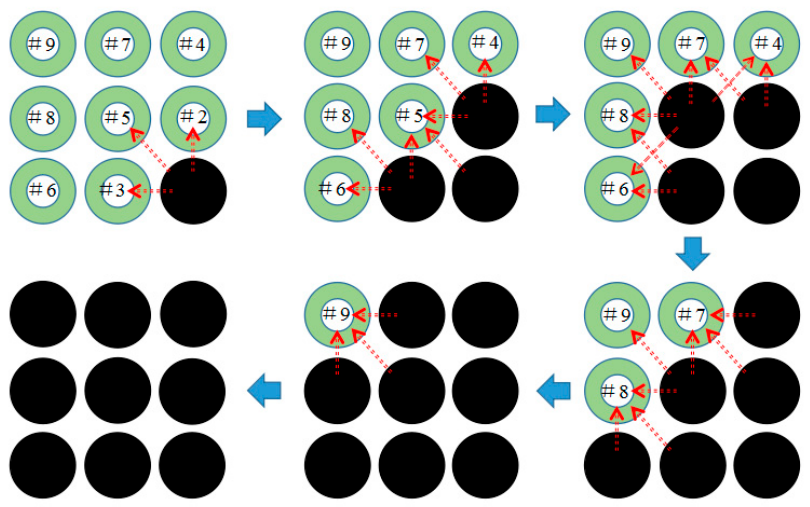
Figure 5. Schematic of thermal failure propagation.